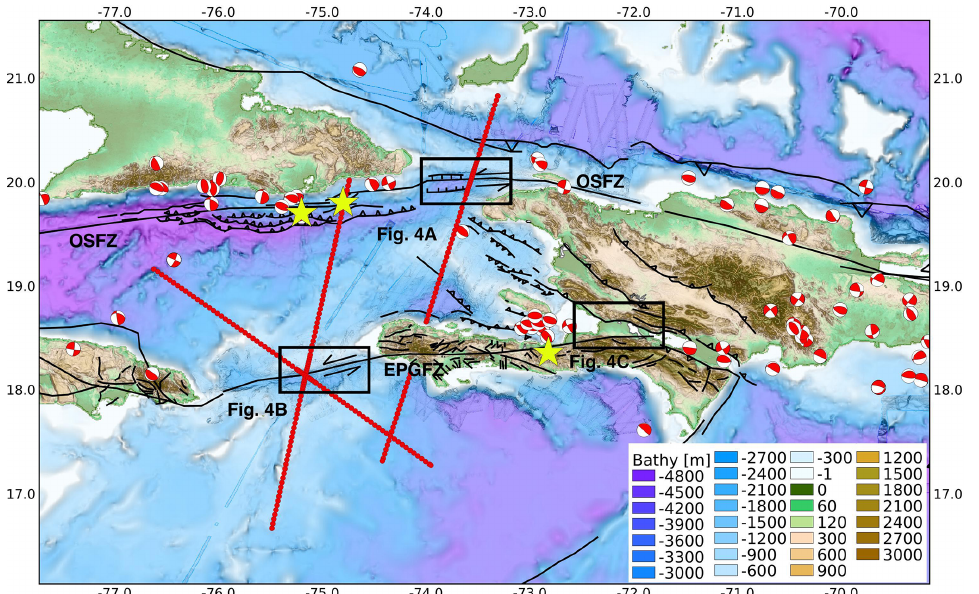
Figure 3. Recent seismotectonics of the northern Caribbean region and offshore survey plan. Red beach balls – earthquake focal mechanisms from the Harvard centroid-moment-tensor (CMT) catalog from 1976 to 2019; yellow stars – slow slip and/or tremor observations (Peng et al., 2013; Aiken et al., 2016); red profiles – proposed transects for the Haiti–TWiST cruise (see Sect. 4). The trace of the EPGFZ terminus east of Port-au-Prince, while illustrated, is actually unknown. Boxes show the locations of panels in Fig.